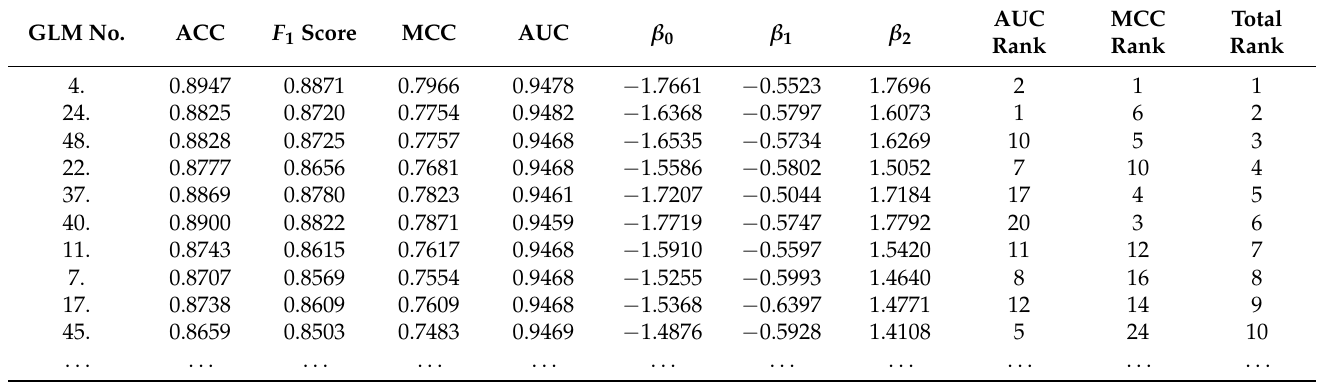
Table 5. TOP 10 GLM models sorted by the combined ranking of AUC rank and MCC rank with equal weights and other parameters.